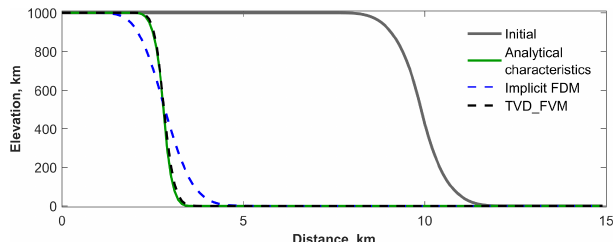
Figure 1. Solution of the linear one-dimensional stream power law for a synthetic knickzone over a time span of 1My. The analytical solution is obtained with the method of characteristics. The spatial resolution is 100m. Table 1 lists other model parameter values.